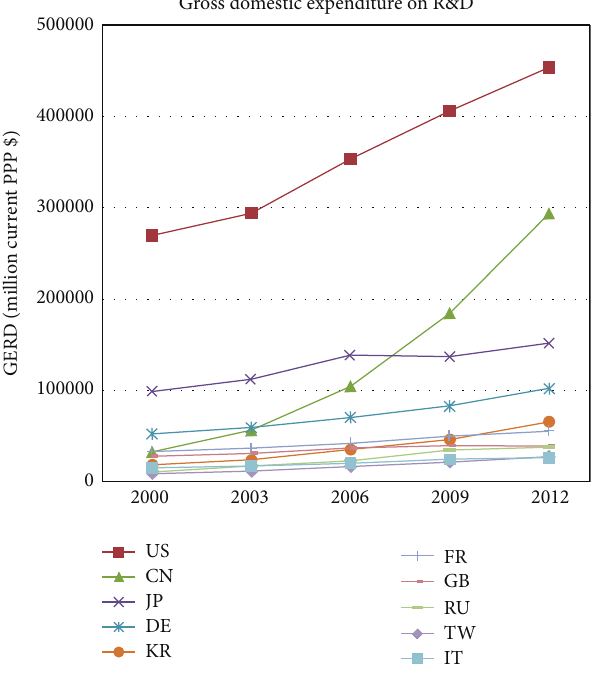
Figure 1: Gross domestic expenditure on the R&Ds (reedition of OECD’s data in